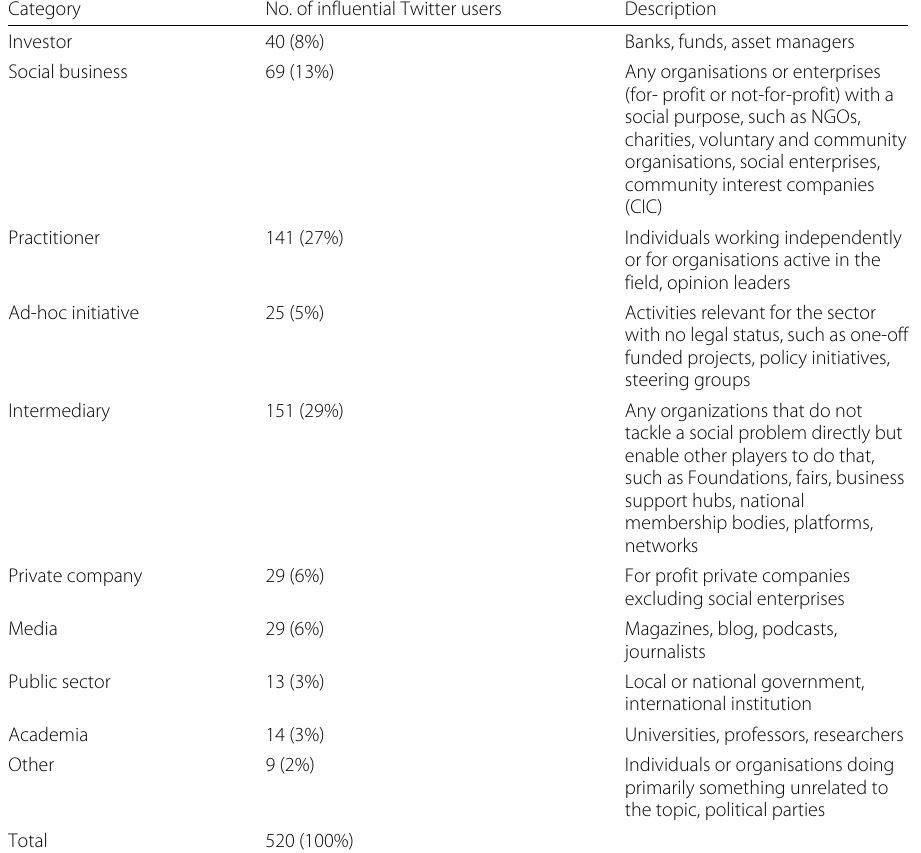
Table 2 Twitter user categories, the number of influential users (with h-index ≥ 5) in each category, and its